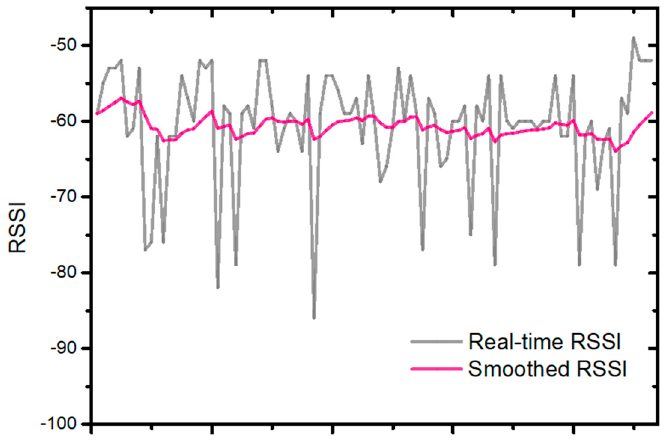
Figure 3. The curves of smoothed RSSI and real-time RSSI.